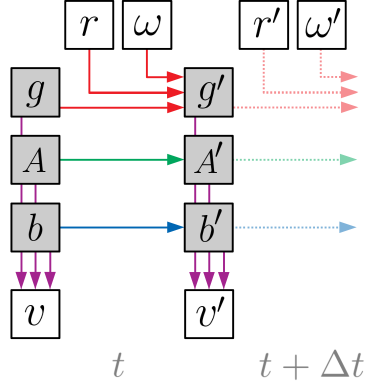
Figure 2: Dynamic Bayesian network for the model. Each node represents a variable and each arrow represents a conditional dependency (color-coded to match Table 2). The shaded nodes are the “hidden” states to be inferred, while the clear nodes are observed. The lighter dotted arrows indicate that this structure repeats for all time- steps ( t + n ∆ t ∀ n ∈ N ). Note that the arrows connecting g , A , and b to v are passing underneath the nodes that they cross without arrowheads.